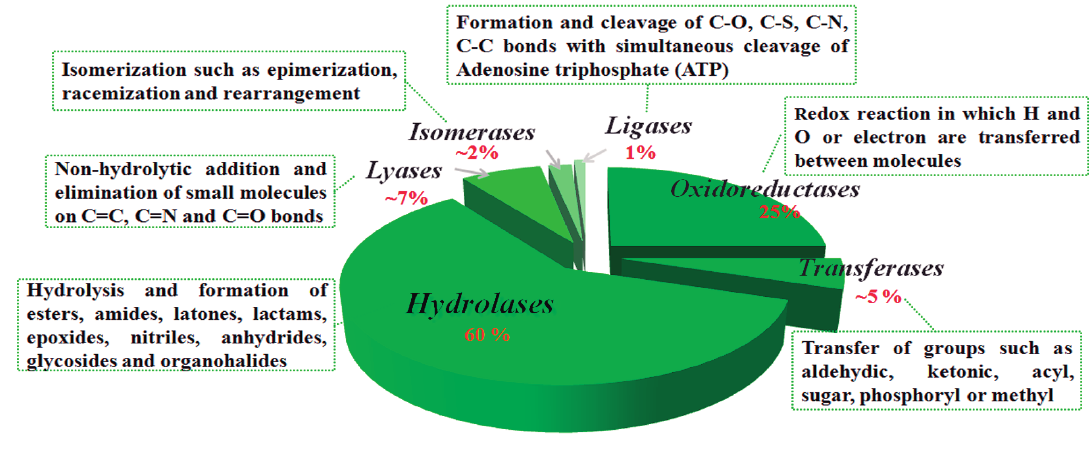
Figure 1. Classification and function of enzymes. Reprinted with permission from